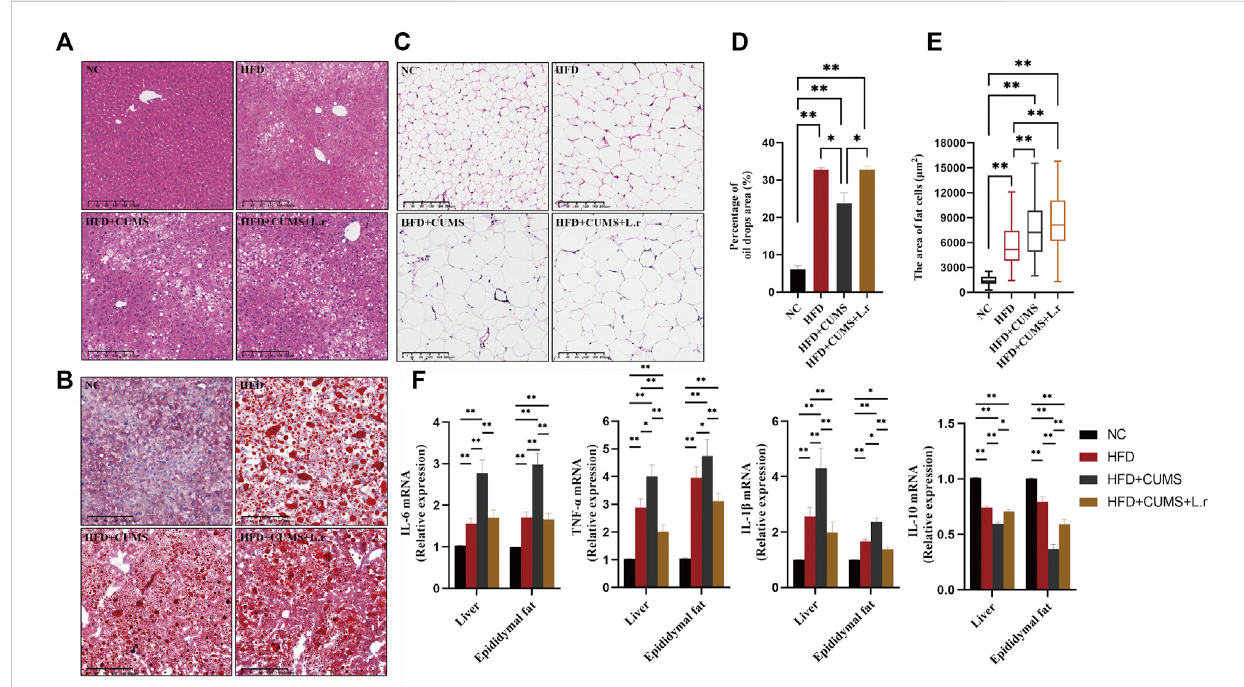
FIGURE 6 Gavagedwith Lactobacillusreuteri reducedin fl ammationinliverandadiposetissues( n =8 – 9/group). (A) H&Estainingofthelivertissues. (B) OilRed O staining of the liver tissues. (C) H&E staining of the epididymis fat tissues. (D) Percentage of oil drops area of the liver tissue. (E) Fat cells area of the epididymisfattissue. (F) mRNAexpressionlevelsofIL-6,TNF- α ,IL-1 β ,andIL-10intheliverandepididymisfattissues.Dataareshownasthemean±SEM. * p < 0.05, ** p < 0.01 (Statistical comparisons between the two groups were performed using the two independent samples t -test. Comparisons between multiple groups were performed using One-way ANOVA and Tukey